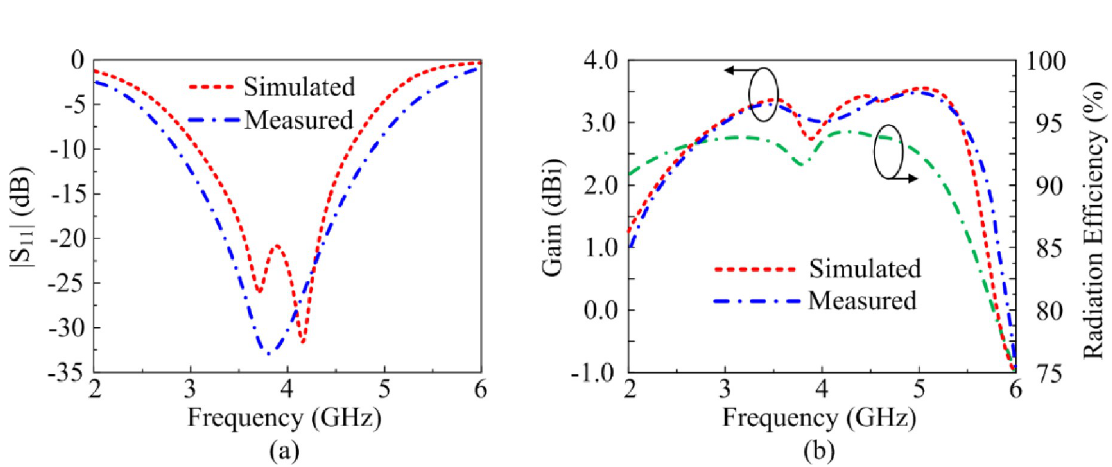
Fig 5. The reflection-coefficient, gain and radiation efficiency response of the proposed antenna when both PIN diodes are reverse biased.